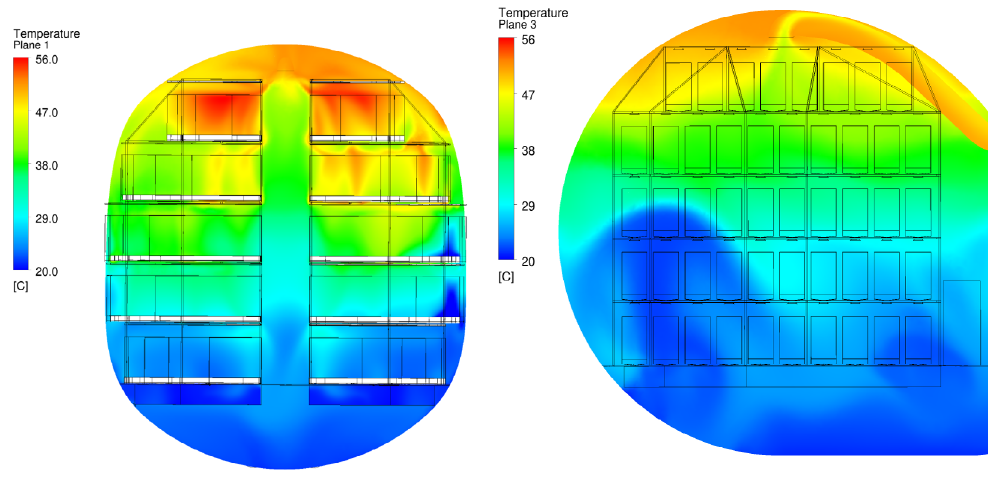
Figure 18: Temperature distribution for both planes (left front view, right side view) for one simulation case (durum